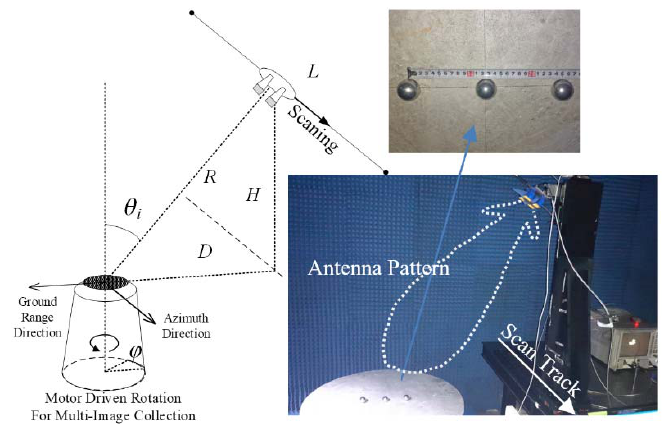
Figure 3. Configuration of the indoor imaging measurement (sketch and photo). The 3 small spheres were utilized to compensate the antenna pattern effect. Table 2. Imaging parameters for different resolution cell size ( R = 1.4 m, ground range resolution, Kaiser windows ( β = 2.5) applied in both domains).